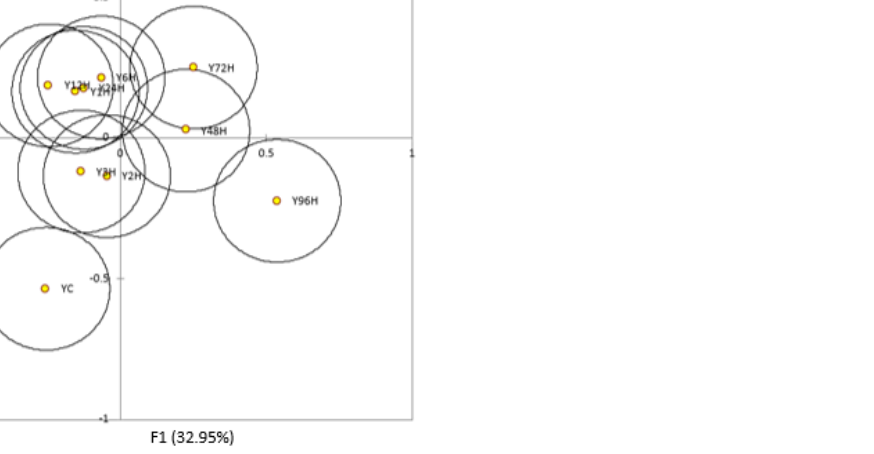
Figure A1. Canonical variates analysis (CVA) score plot of young treatments showing 95% confidence intervals and groupings.